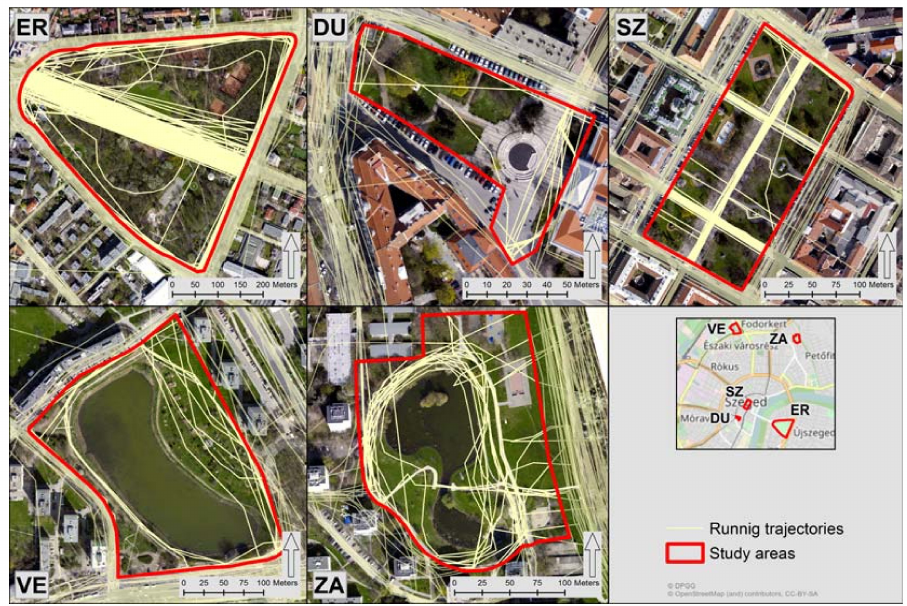
Figure 2. Running trajectories touching or crossing the grounds of the study areas. ER: Erzs é bet liget; DU: Dugonics t é r; SZ: Sz é chenyi t é r; VE: V é r-t ó ; ZA: Z á por-t ó . Figure created by the authors. Sources of base maps: [51,59].